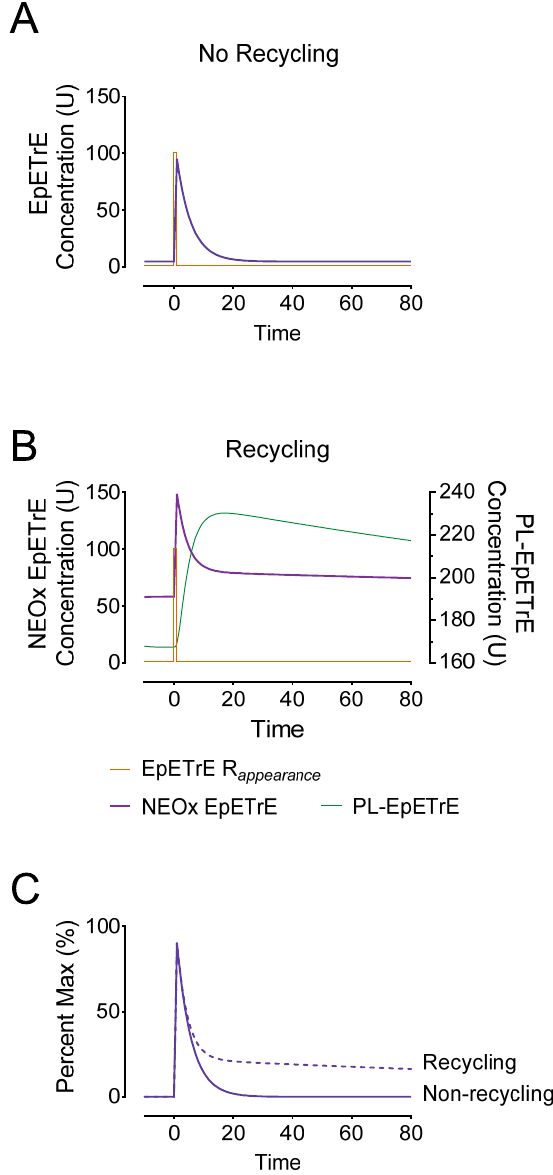
Figure 3. Comparison of non-recycling systems to recycling systems. To graphically illustrate the potential consequences of sequestering EpETrEs into membrane phospholipids, we developed a simulation based on the model in Figure 2. We simulated both basal EpETrE synthesis at 1 U/min and an adaptive response to stimulate EpETrE production, as a 100-fold increase in EpETrE production to 100 U/minute beginning at time = 0 and lasting for 1 min (EpETrE R appearance ). Model ( A ) represents the system with no recycling in which all of the fractional clearance (FCR = 0.21) is from the cytosolic NEOx to permanent disposal, as would be the case if EpETrE disposal occurs entirely in